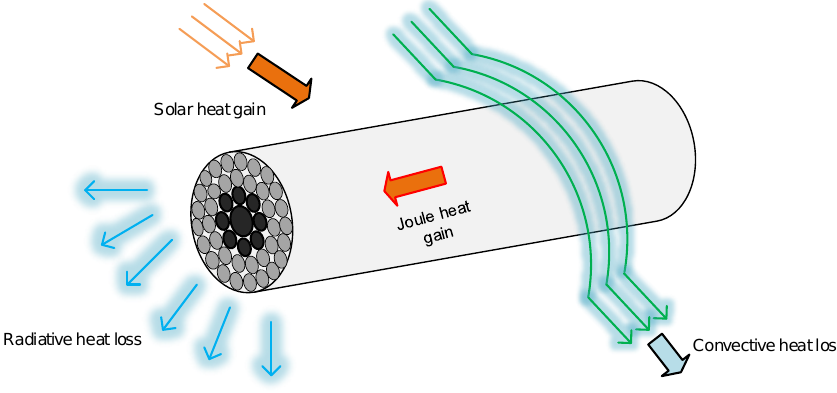
Figure 1. Heat balance of an overhead